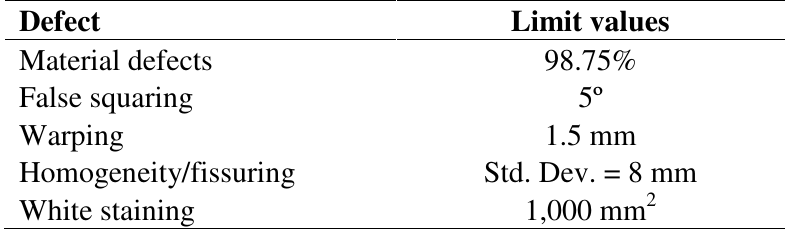
Table 1. Defects and limit values established for this